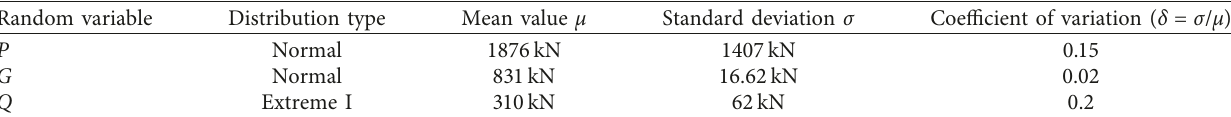
Table 4: Statistics of random variables.